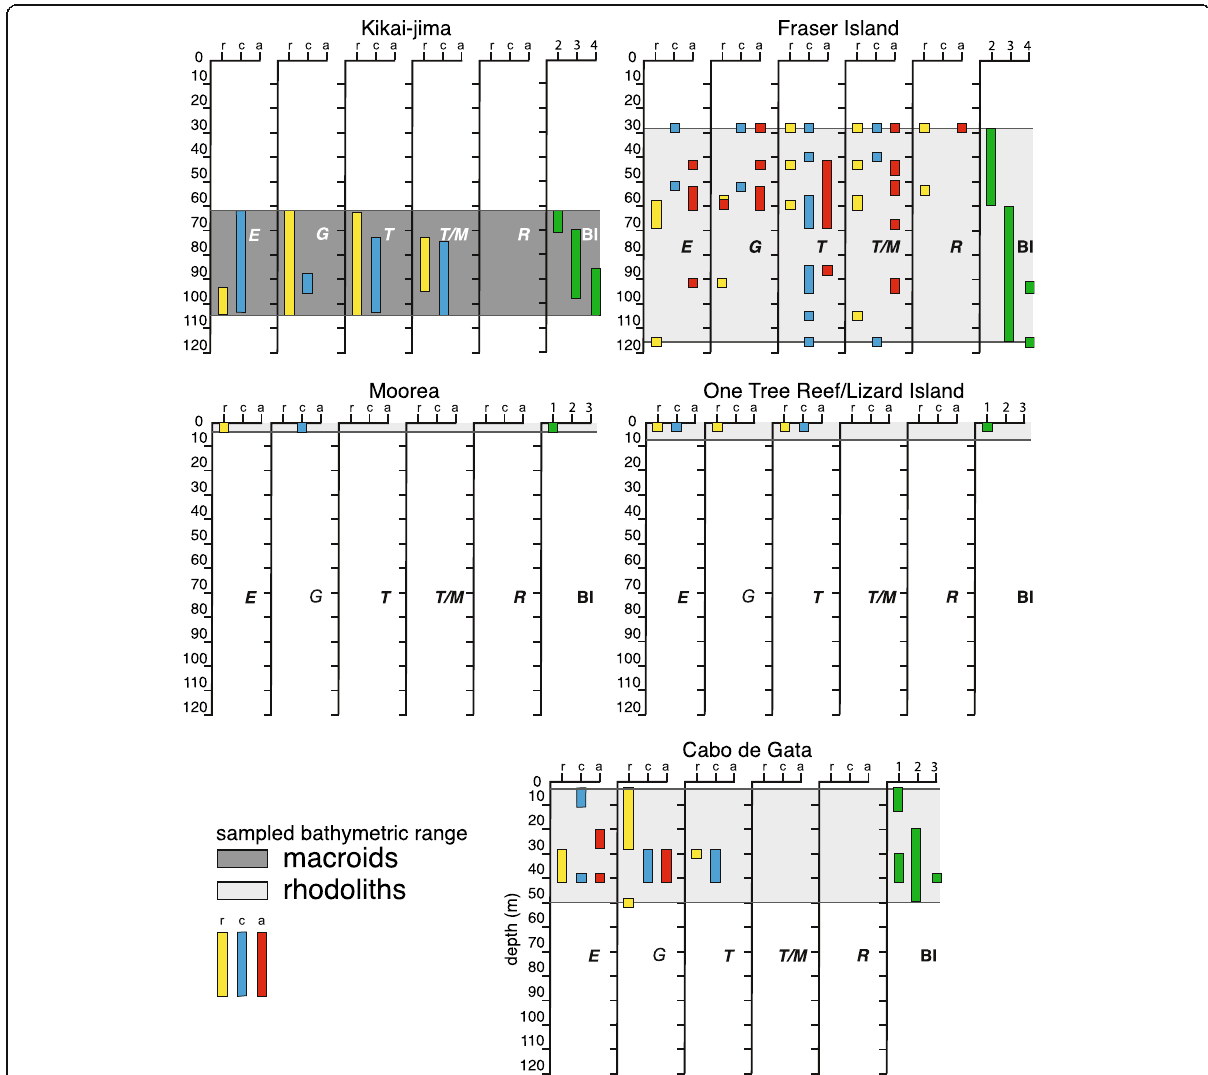
Fig. 7 Distribution of the ichnogenera, their relative abundance in the studied areas, and the bioerosion index (BI). The distribution of samples is plotted according the different sampling methods (see text for details). The sampled bathymetric range of the studied beds is also reported (depth intervals are dark gray for macroids and gray for rhodoliths). E , Entobia ; G , Gastrochaenolites ; T , Trypanites ; T / M , Trypanites / Maeandropolydora ; R , Rogerella ; r, rare; c, common; a,